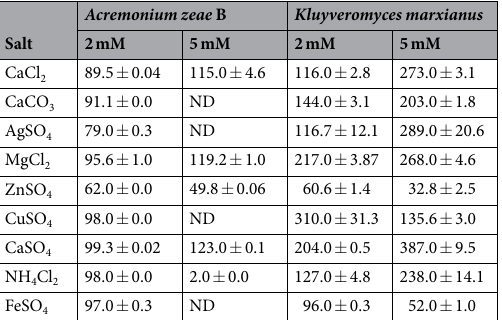
Table 1. Effect of ions on phytase activity in Acremonium zeae B and Kluyveromyces marxianus extracts. Data are expressed in terms of relative activity considering 100% the activity in the extract without addition of ions. ND = activity not detected in the condition tested. ± standard deviation corresponding to the mean of